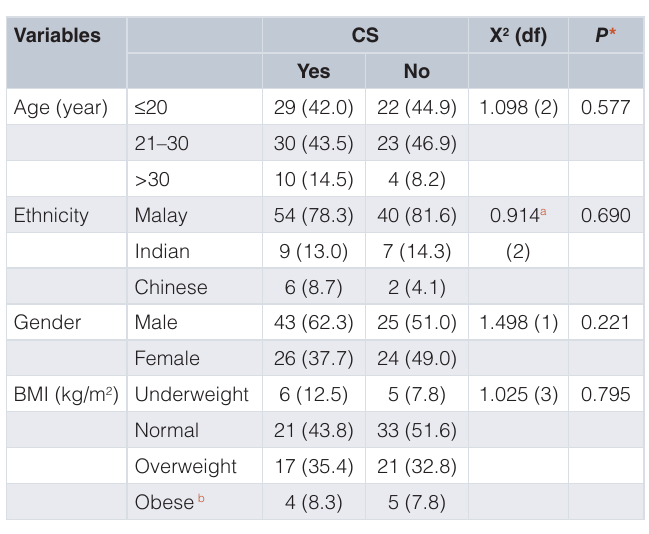
Table 6. Association between patient characteristics and compensatory sweating (CS) in 118 patients following endoscopic thoracic sympathectomy.